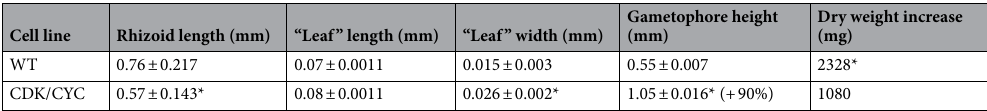
Table 2. Comparison of cell area and gametophore height of WT and transgenic cell lines. Rhizoid, “leaf” and gametophore height of cells (n > 10) grown in BCD medium for 90 days. The dry weight started at 410 mg (WT) and 440 mg (CDK/CYC). Significance of the data was determined by one-way ANOVA test; P < 0.001 marked with an